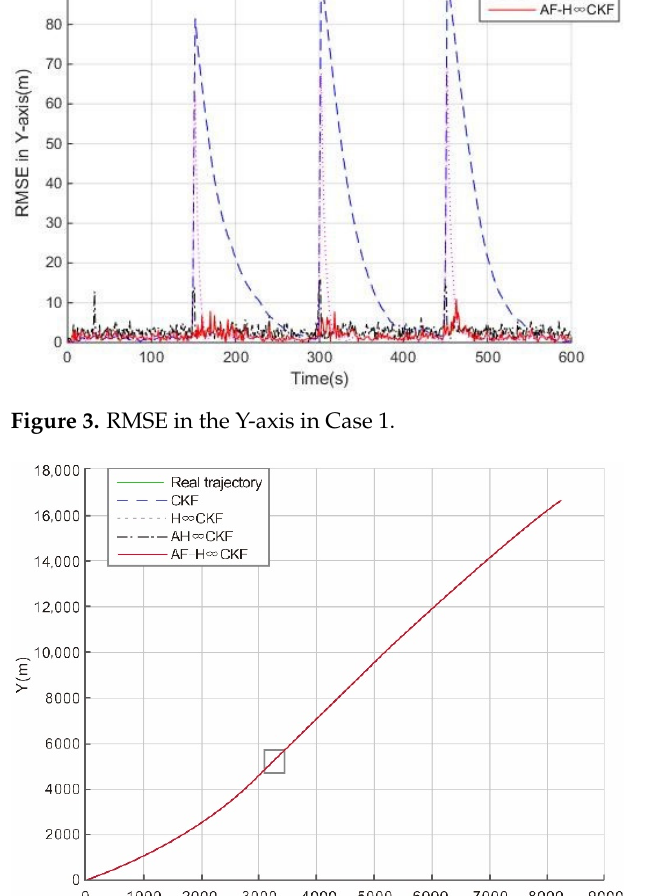
Figure 5. Partial enlargement of Figure 4.